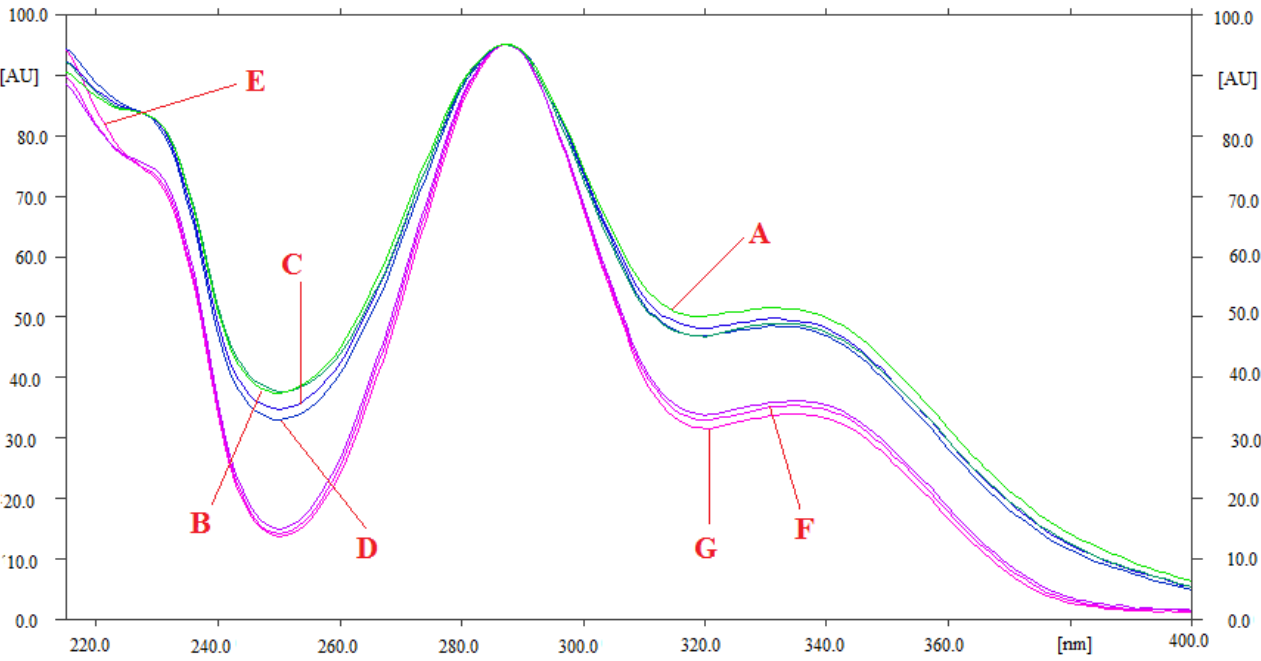
Figure 3. Overlaid spectrodensitograms of ( A ) standard HSP, ( B ) grapefruit peels, ( C ) lemon peels, ( D ) mosambi peels, ( E ) orange peels, ( F ) commercial formulations A, and ( G ) commercial formulations B.